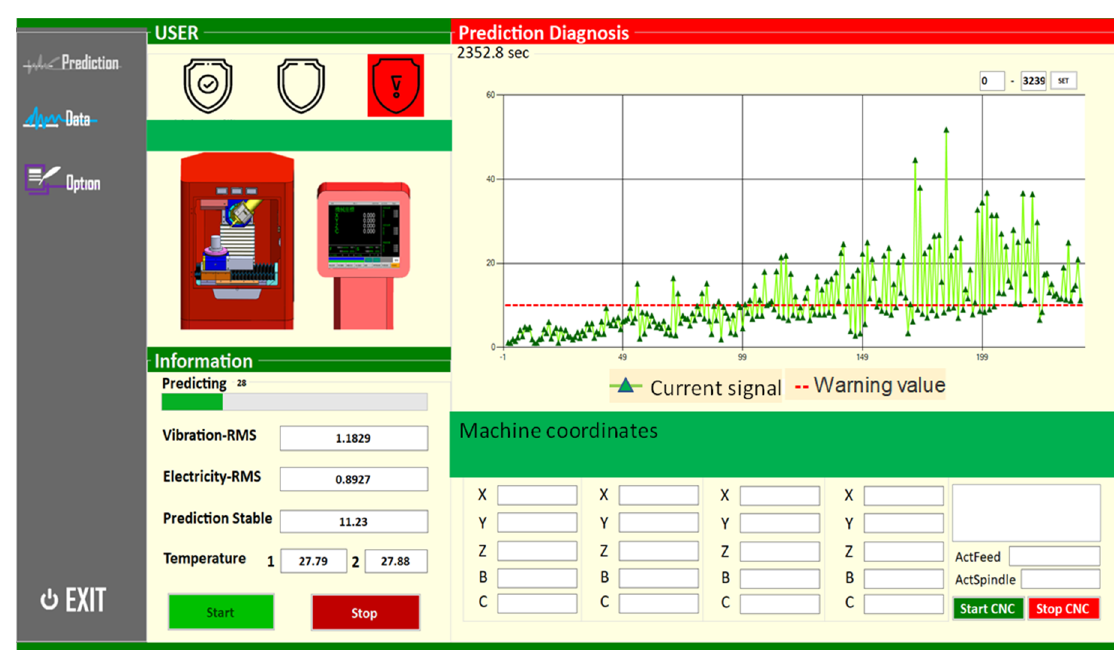
Figure 14. Online prediction and